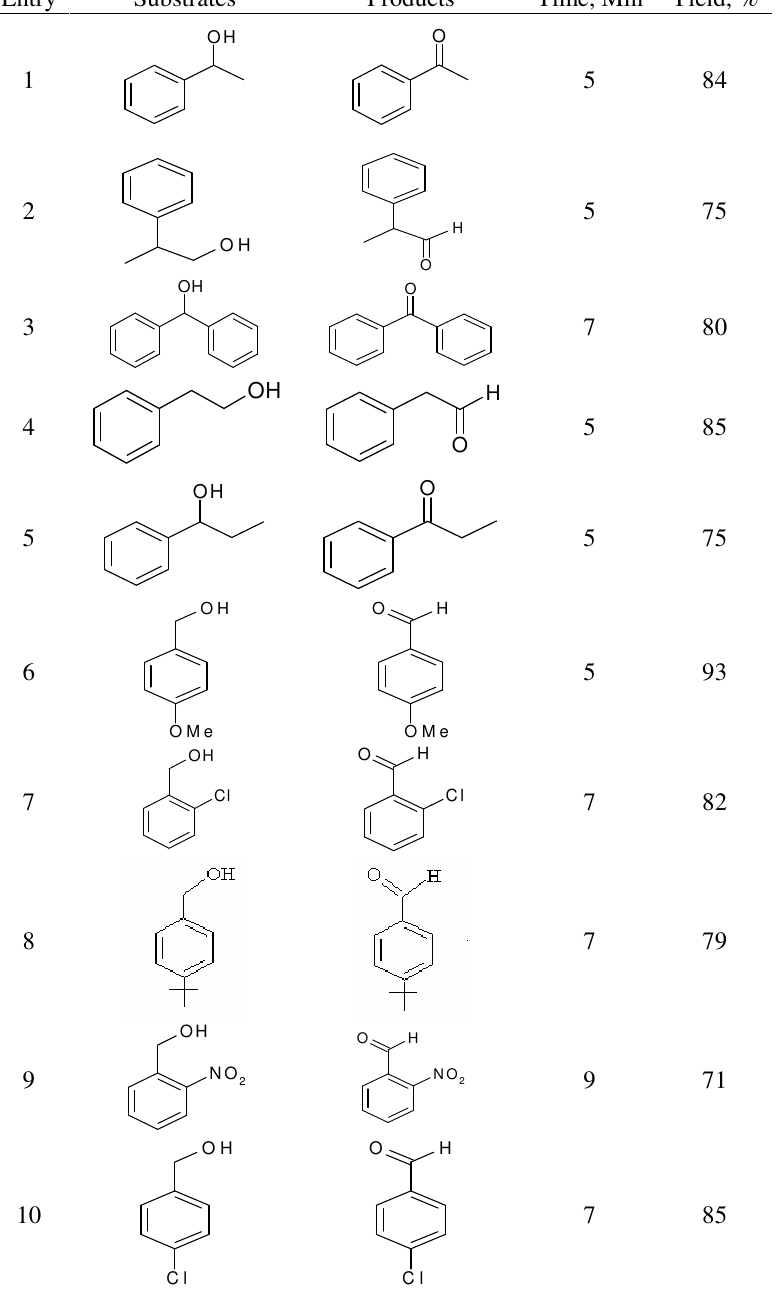
Table 1. Oxidation of alcohols by means of nickel peroxide/silica gel system